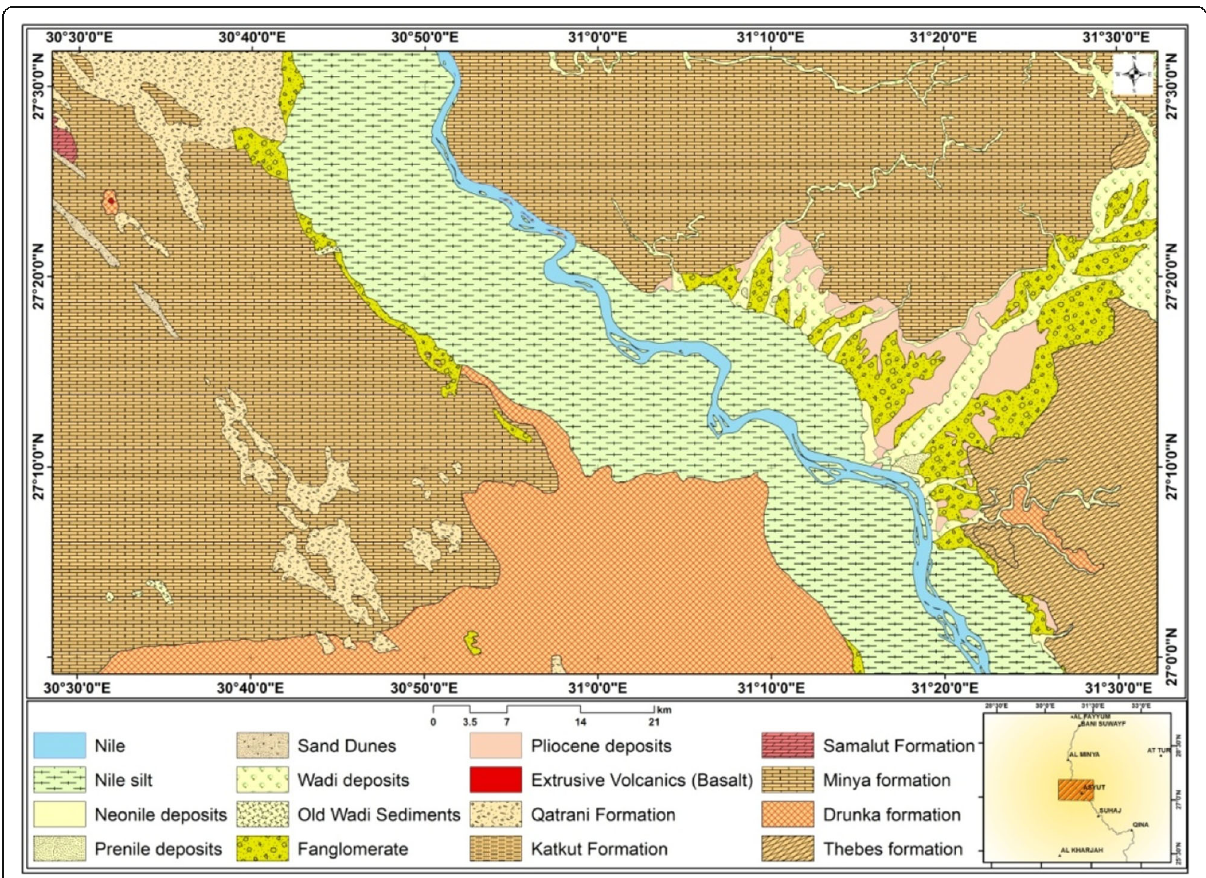
Fig. 3 Geological map of Assiut Governorate, Egypt (Mansour and Philobbos